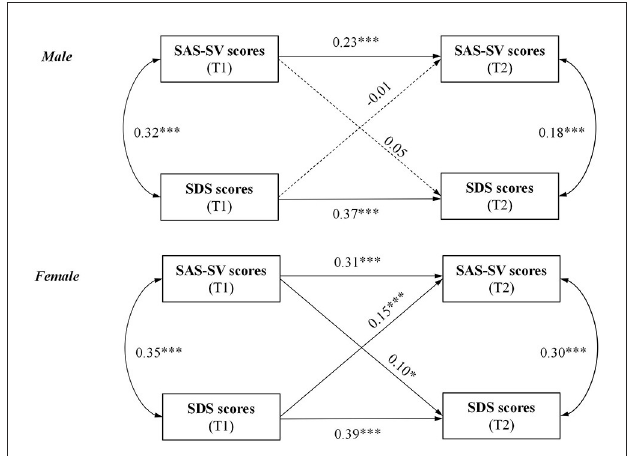
FIGURE2 Path diagram of the CLPM by gender. * P < 0.05; ** P < 0.01; *** P < 0.001; T1, assessed at baseline; T2, assessed at follow-up. SAS-SV, Smartphone Addiction Scale-Short Version; SDS, Zung’s Self-Rating Depression Scale; Single-headed arrows denote regressions, double-headed arrows denote correlations; Solid lines present statistically significant associations and dashed lines present nonsignificant